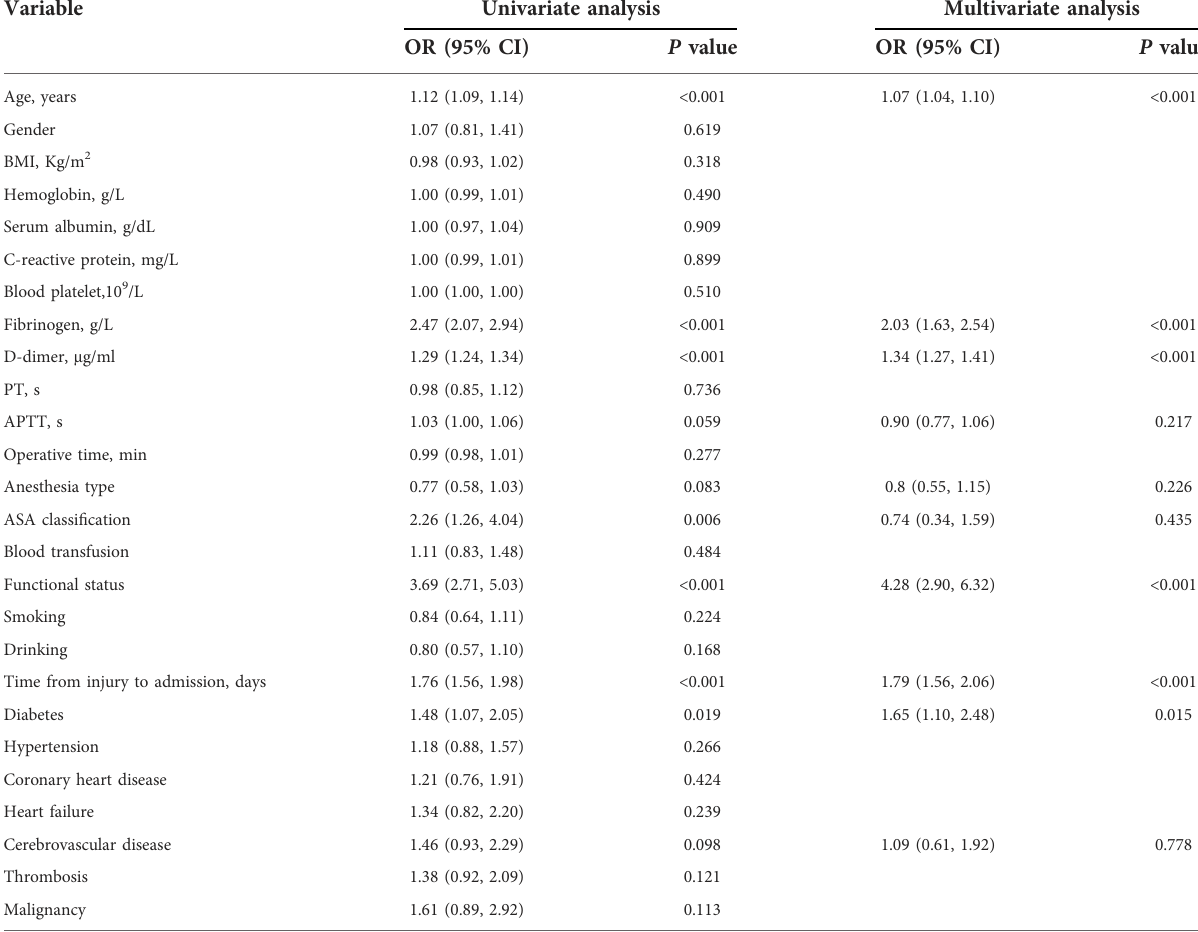
TABLE 2 Univariate and multivariate logistic regression of predictors for